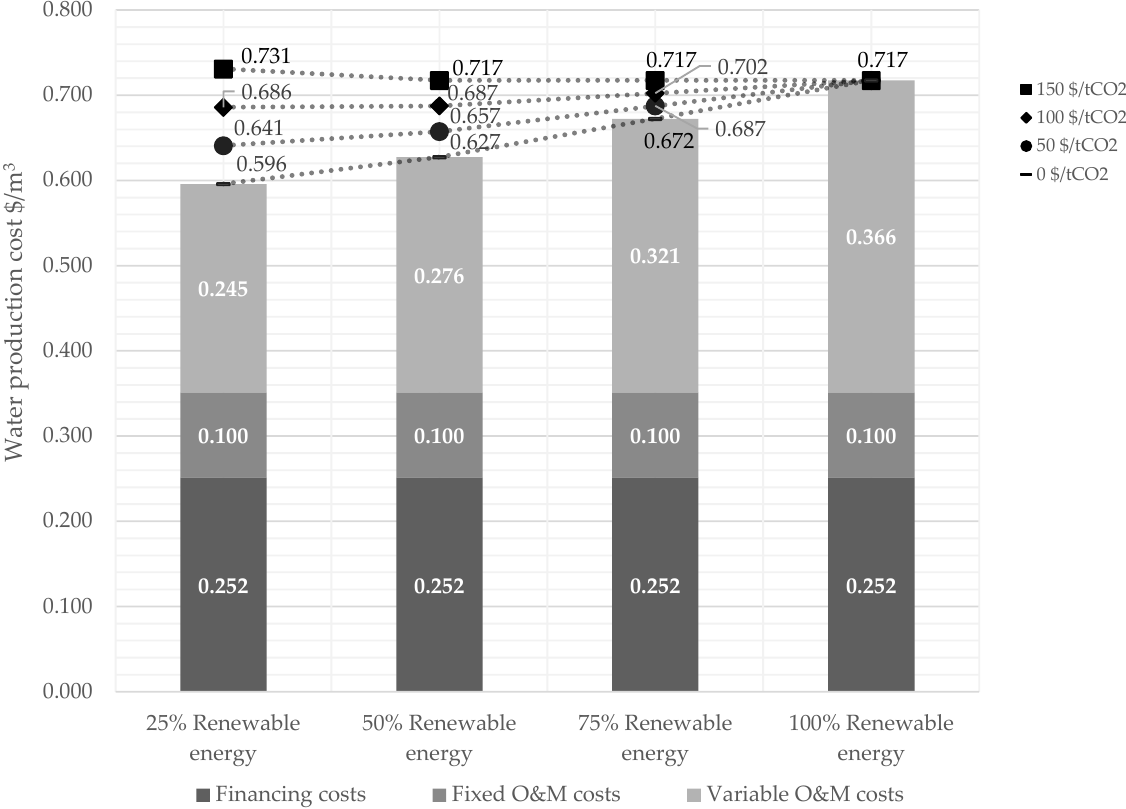
Figure 8. Comparison of the specific water production cost varying the share of renewable energy for alternative No. 3.